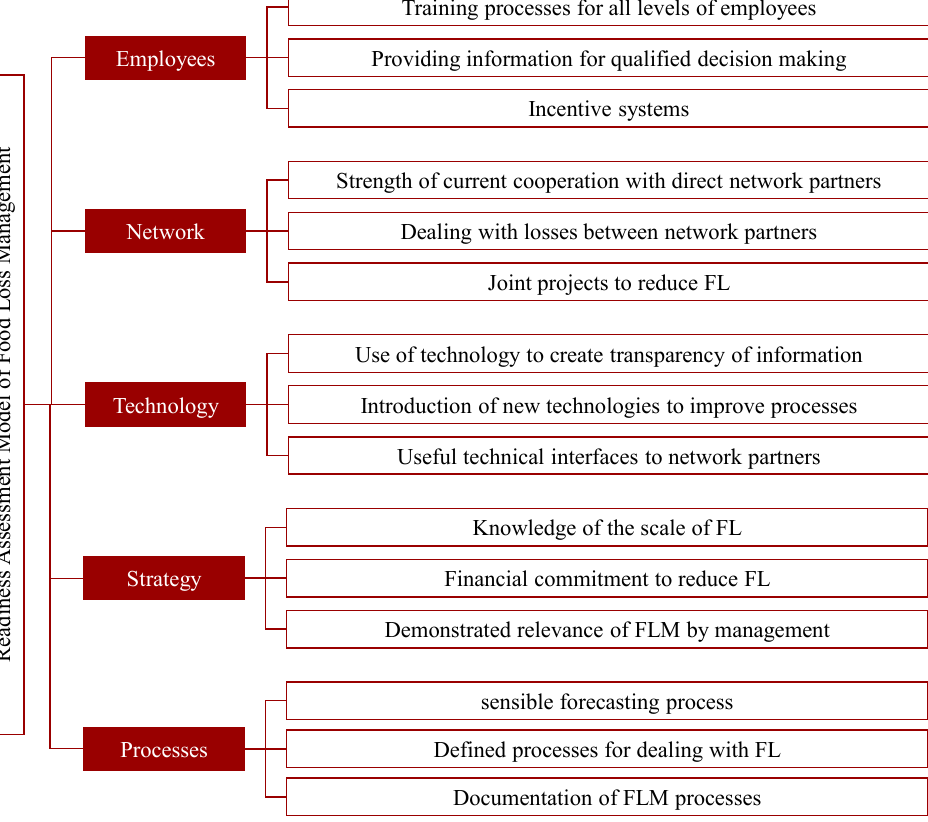
Figure 3. Readiness assessment model of food loss management in logistics [15].